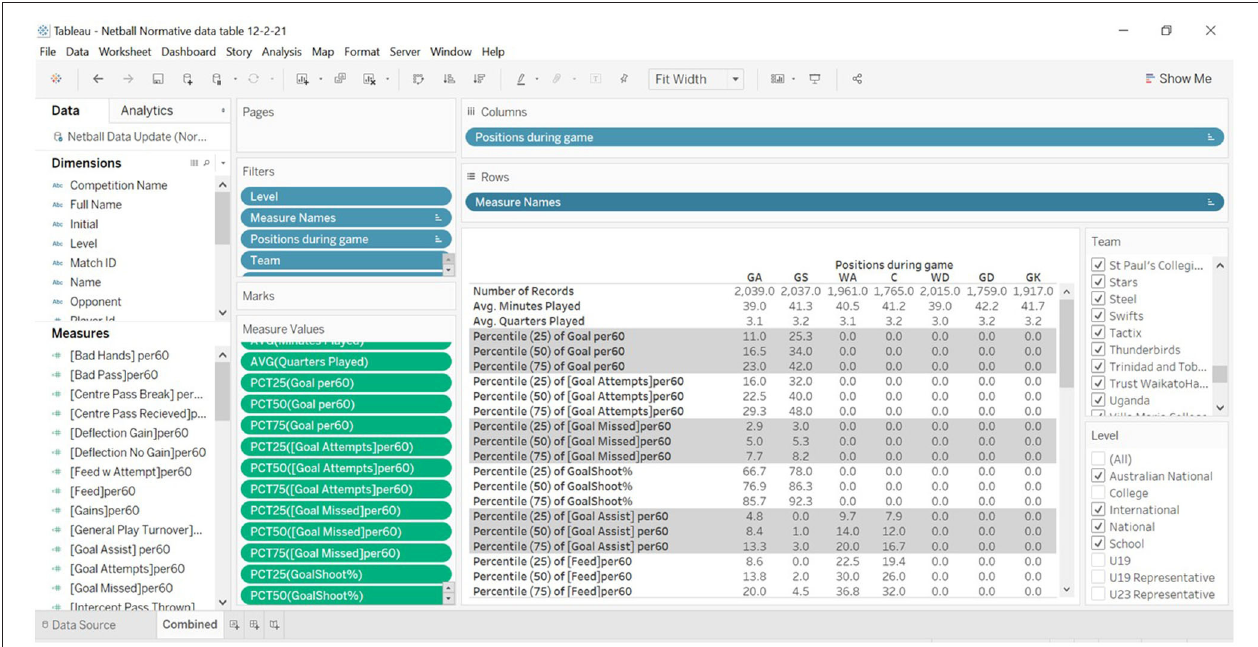
FIGURE 2 | Layout of Tableau TM reporting interface with filters (right side) for competition, level, and year present.